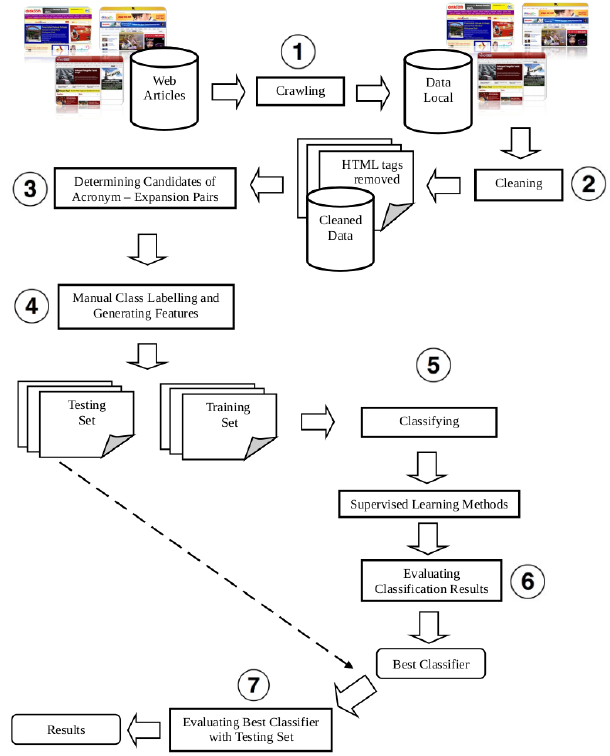
Figure 1. The proposed